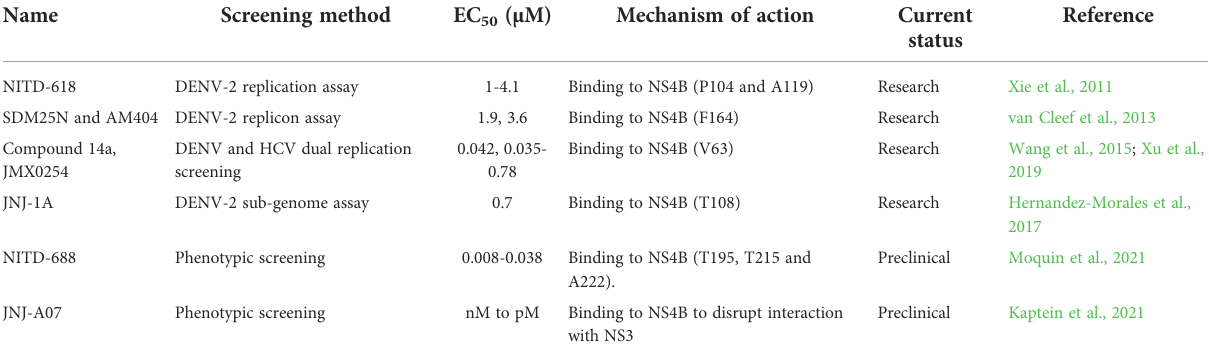
TABLE 1 Some available dengue NS4B